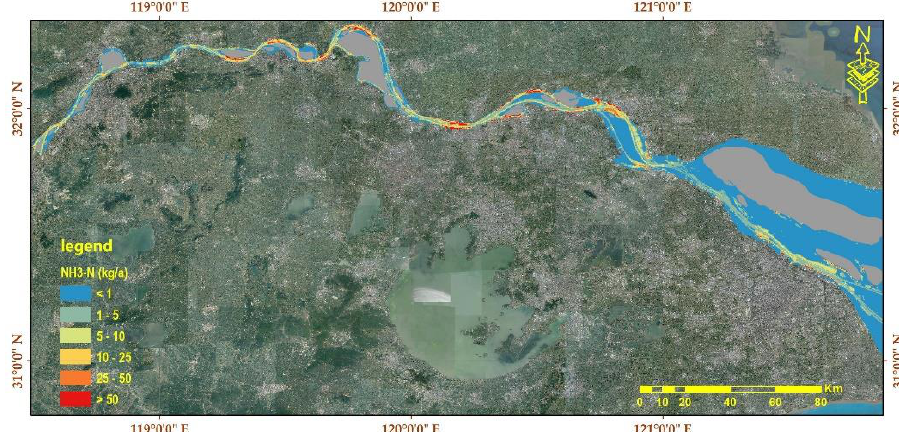
Figure 12. NH 3 -N generation distribution.